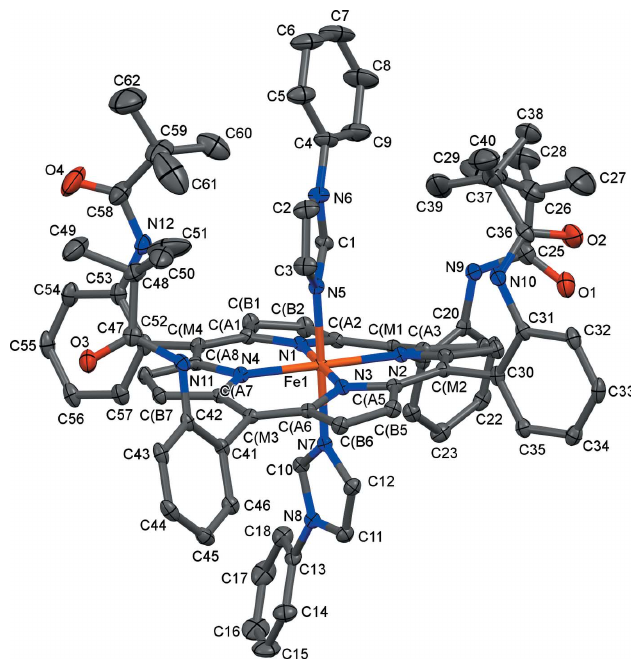
Figure 1 Displacement ellipsoid plot of the bis(1-phenylimidazole)(tetraphenyl- porphinato)iron(III) cation with atom labeling and displacement ellipsoids drawn at the 50% probability level. H atoms are not displayed for